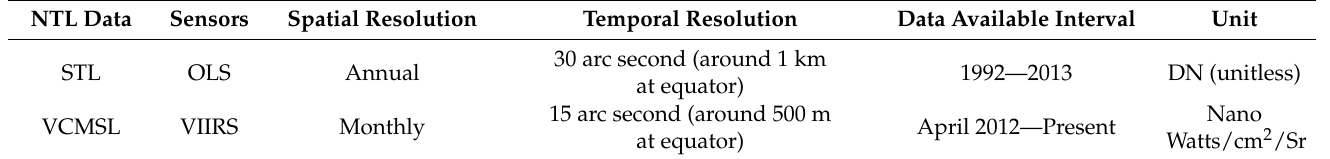
Table 2. Data parameters of DMSP/OLS and